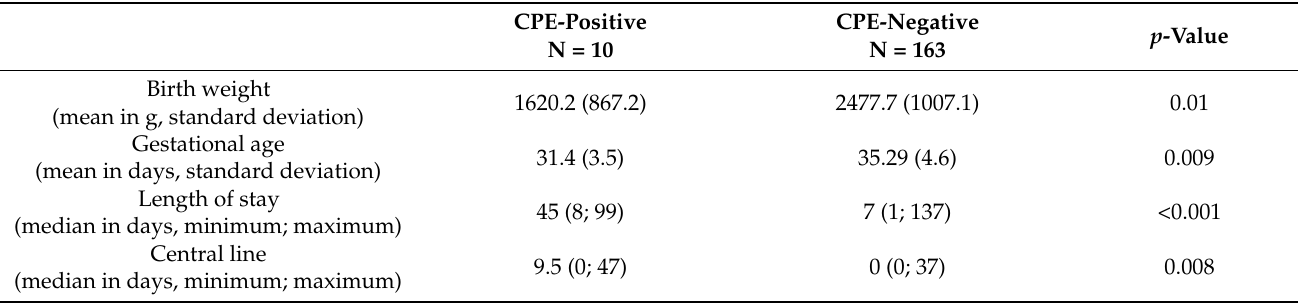
Table 1. Bivariate analysis of risk factors among carbapenemase producing Enterobacterales (CPE) at an neonatal intensive care unit (NICU).